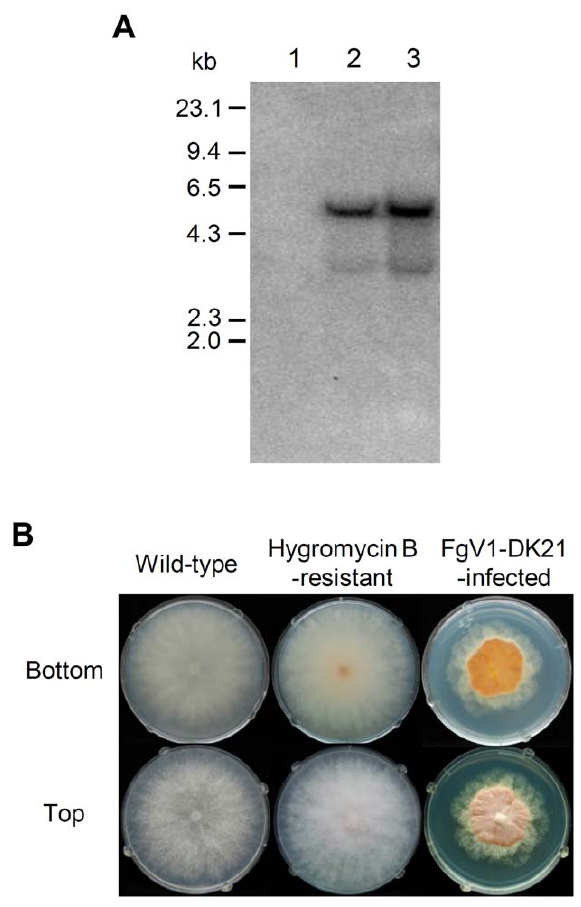
Figure 1. Transformation of F.graminearum with a hygromycin B resistance gene. (A) Southern blot hybridization of Kpn I - digested genomic DNAs. Hygromycin B-resistant transformants were obtained by transforming the fungal protoplasts with the plasmid pUCH1. The probe used was Eco R I and Hind III fragment (1.4 kb) from pUCH1 bearing the hygB structural gene. Lane M, l DNA- Hind III digested DNA marker; lane 1, wild-type; lane 2, hygromycin B-resistant strain; lane 3, virus-infected strain (protoplast fusant). (B) Photograph of fungal colonies 4 days after inoculation.